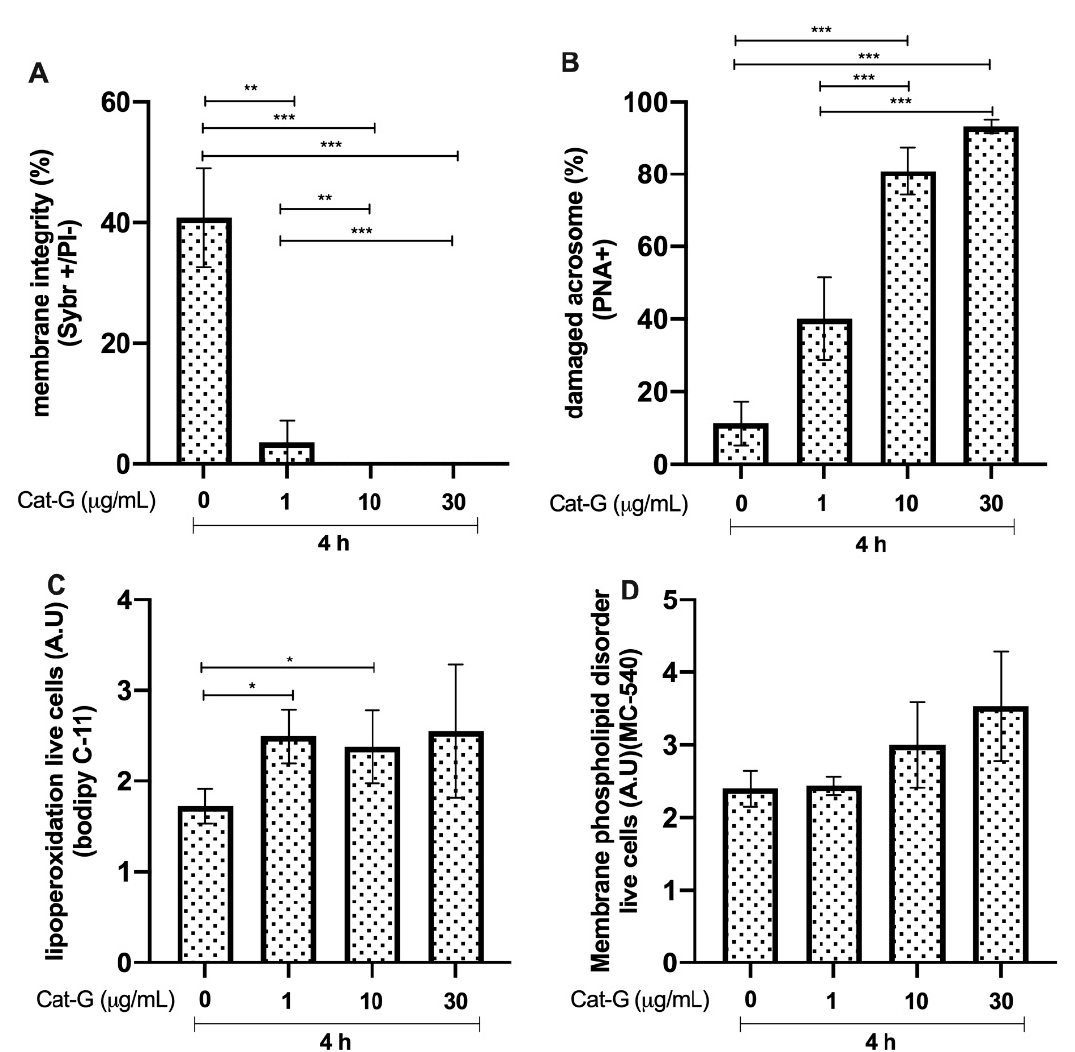
Figure 5. Effect of different concentrations of cathepsin G (Cat-G) on bull sperm. ( A ) Plasma membrane integrity. ( B ) Damaged acrosomes. ( C ) Lipid peroxidation. ( D ) Membrane phospholipid dis- order. The results are shown as the mean ± standard deviation. The asterisks (*, **, ***) above the bars indicate differences between the groups ( p < 0.05, p < 0.01, and p < 0.0001) based on three bio- logical replicates.